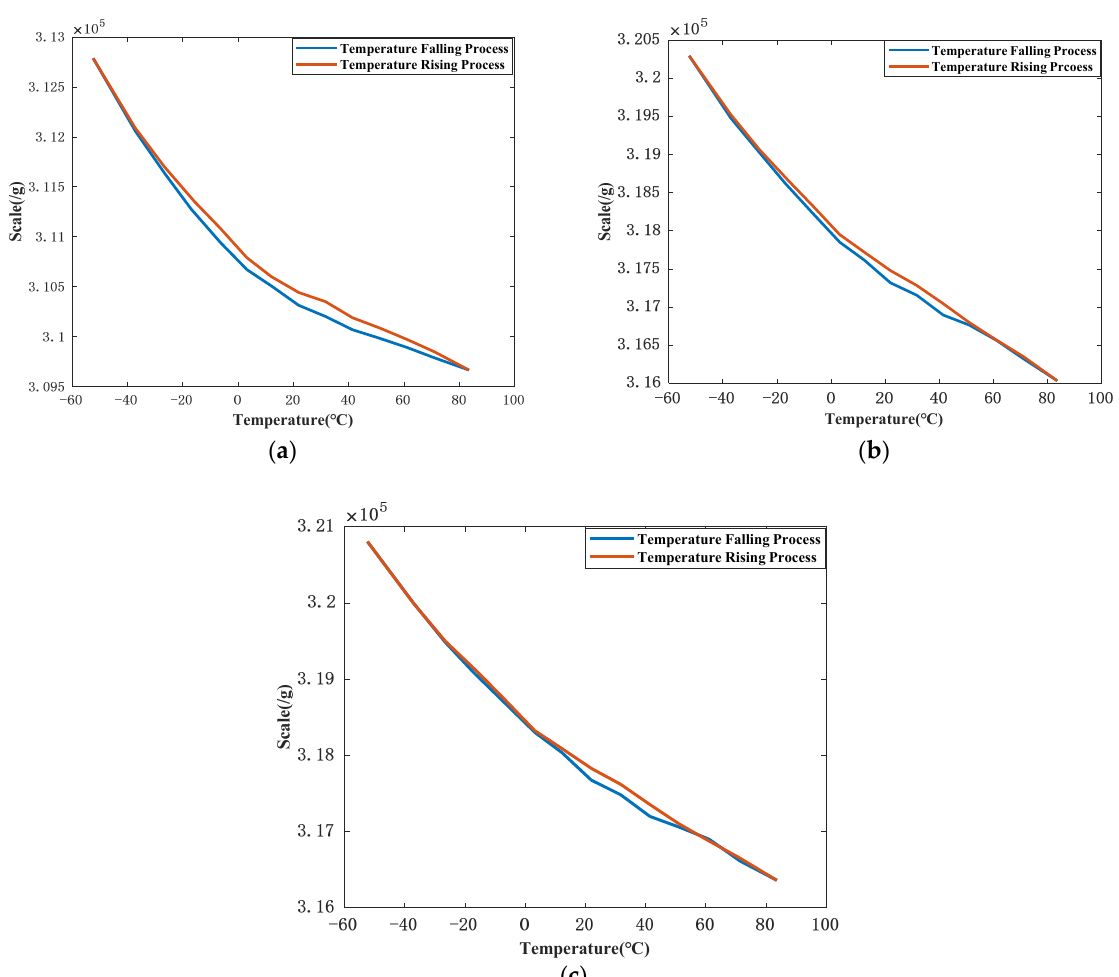
Figure 5. ( a ) is the scale factor of JB ‐ KT8 #1 at different temperature; ( b ) is the scale factor of JB ‐ KT8 #2 at different temperature; ( c ) is the scale factor of JB ‐ KT8 #3 at different temperature.